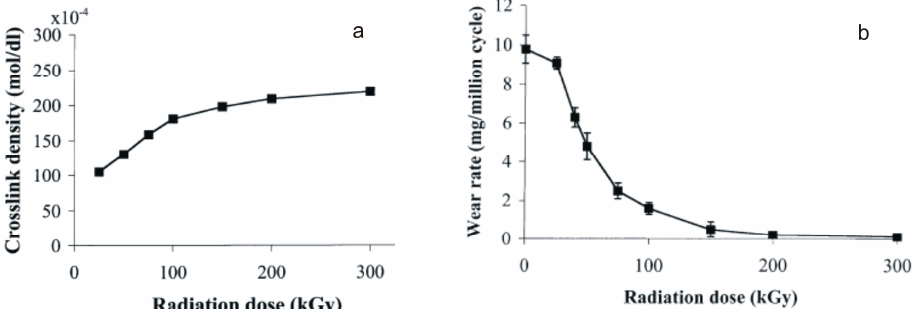
Figure 4. ( a ) Crosslink density and ( b ) pin-on-disk (POD) wear rate of irradiated UHMWPE as a function of increasing dose. Adapted from [42] with permission.